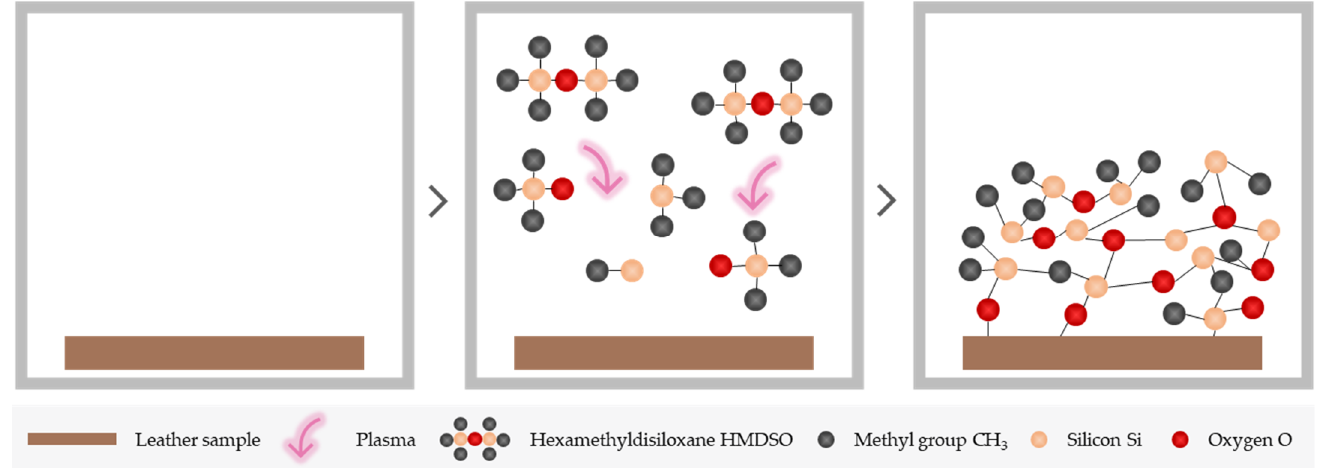
Figure 1. HMDSO single-step plasma polymerisation process.